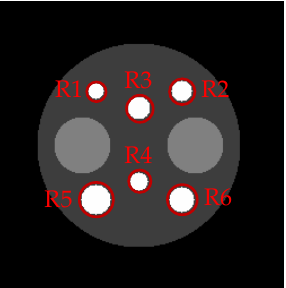
Figure 4. Profile plots for HR anecdotal reconstructions: ( a ) HR phantom with a profile line shown; ( b ) profile plots along the line shown in ( a ) for HR reconstruction methods (NLR, NWMR and SDMR); ( c ) HR phantom with a profile line shown; ( d ) profile plots along the line shown in ( c ) for HR reconstruction methods (NLR, NWMR and SDMR).